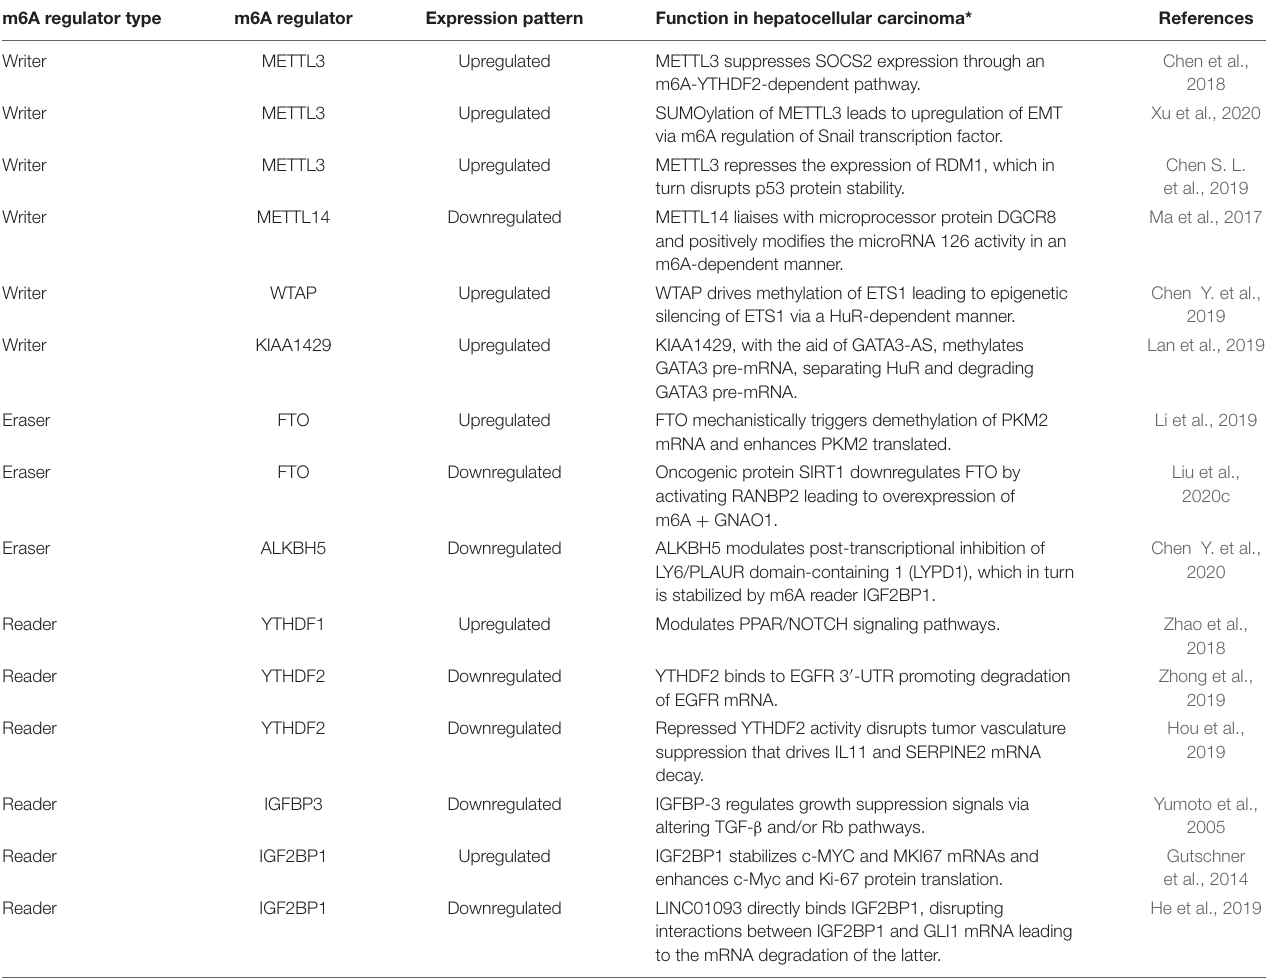
TABLE 1 | Role of m6A methylome in